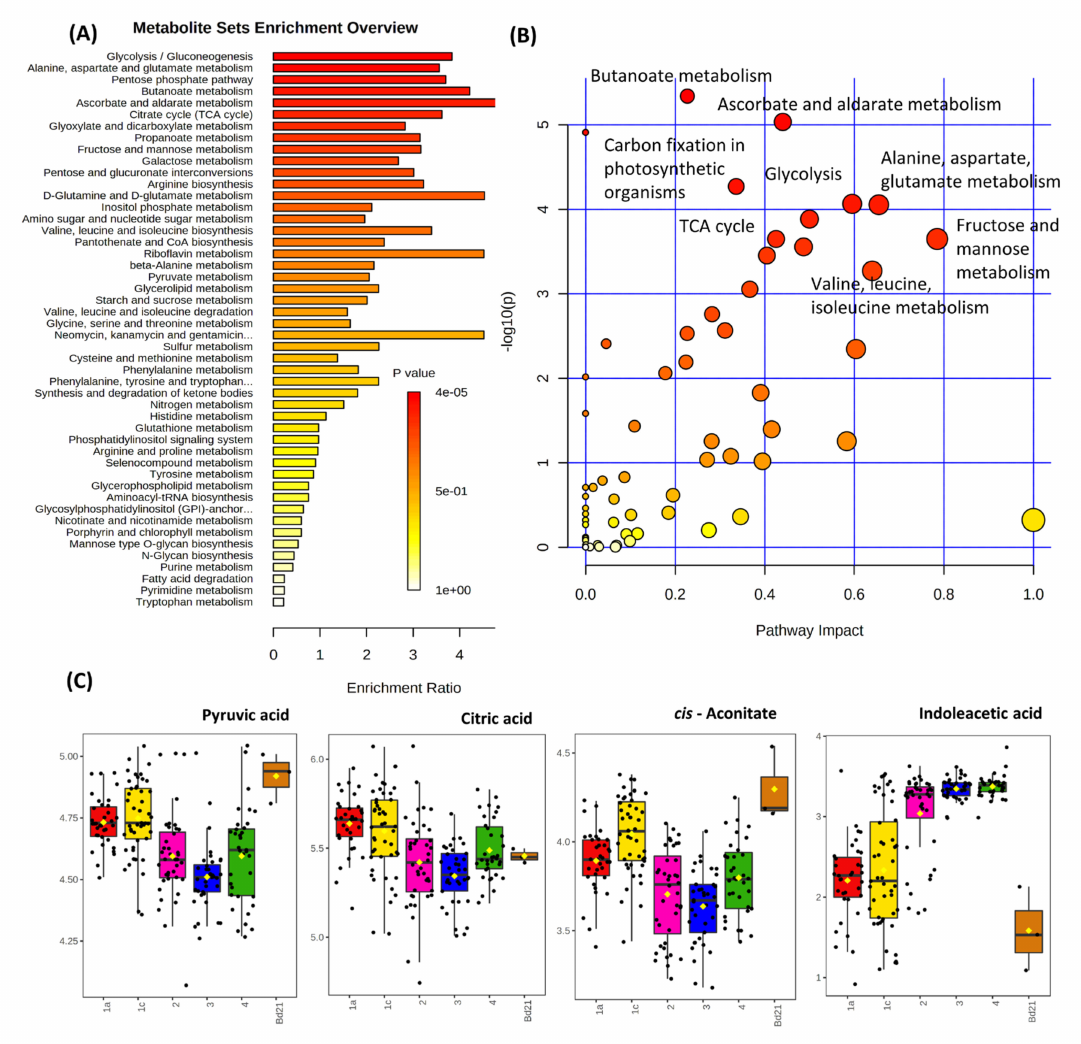
Figure 2. Biochemical pathway and metabolite analyses showing discrimination between Brachypodium metabolomes from different climatic regions of Turkey. FIE-HRMS derived metabolites which exhibited significant (one-way ANOVA correcting for false discovery rates, FDR) differences between accessions from different Turkish regions [6] were assessed using ( A ) metabolite set enrichment analysis (MSEA) or ( B ) the mummichog algorithm where significantly enriched pathways are also ranged for biological impact. ( C ) Exemplar metabolites exhibiting significant differences between accessions from different regions are shown using box and whisker plots. Regions 1a (red), 1c (yellow), 2 (purple), 3 (blue) and 4 (green) are indicated with Bd21 (dark orange) as the reference